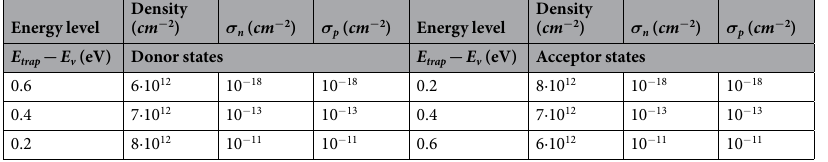
Table 1. Values of the interface trap parameters for the acceptor and donor states included in the simulations shown in Fig. 3.